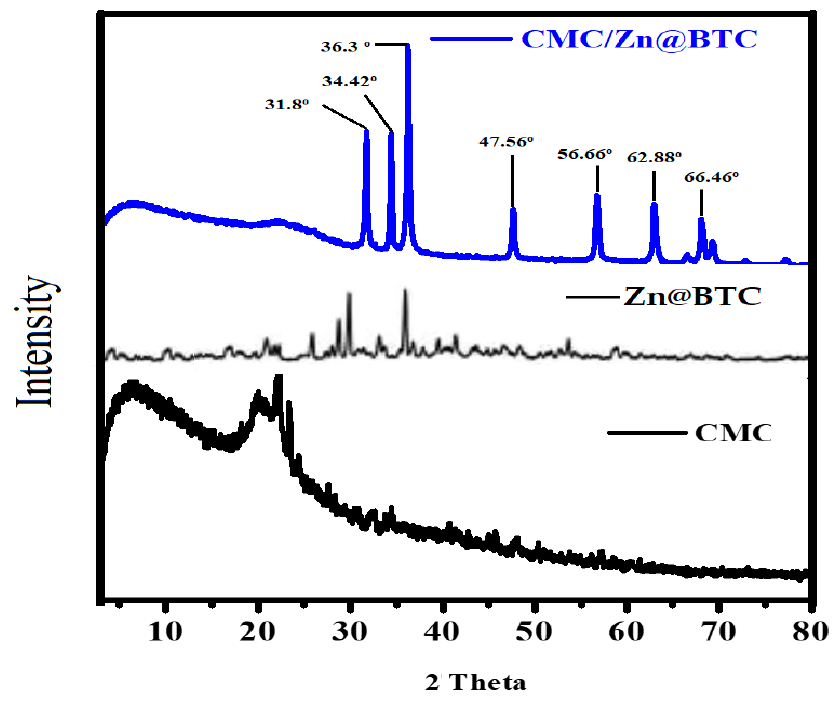
Figure 2. XRD pattern of CMC, Zn@BTC, and CMC/Zn@BTC.